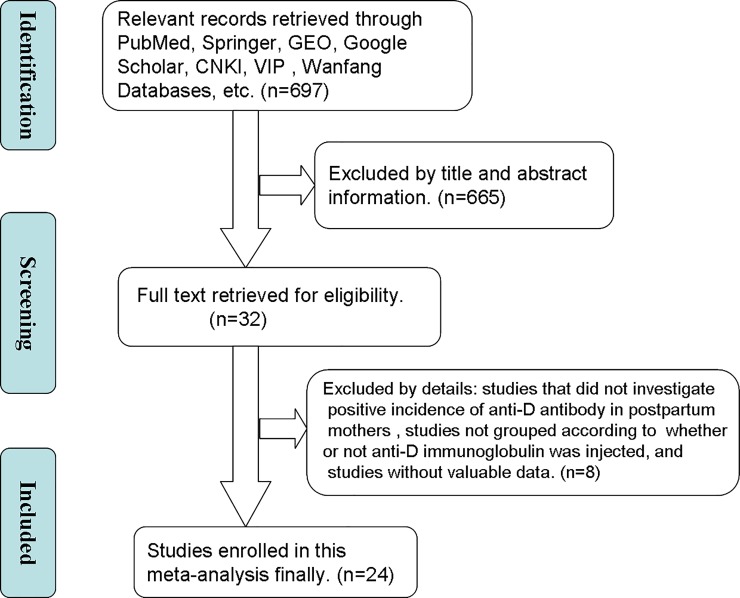
Flow diagram of included studies.